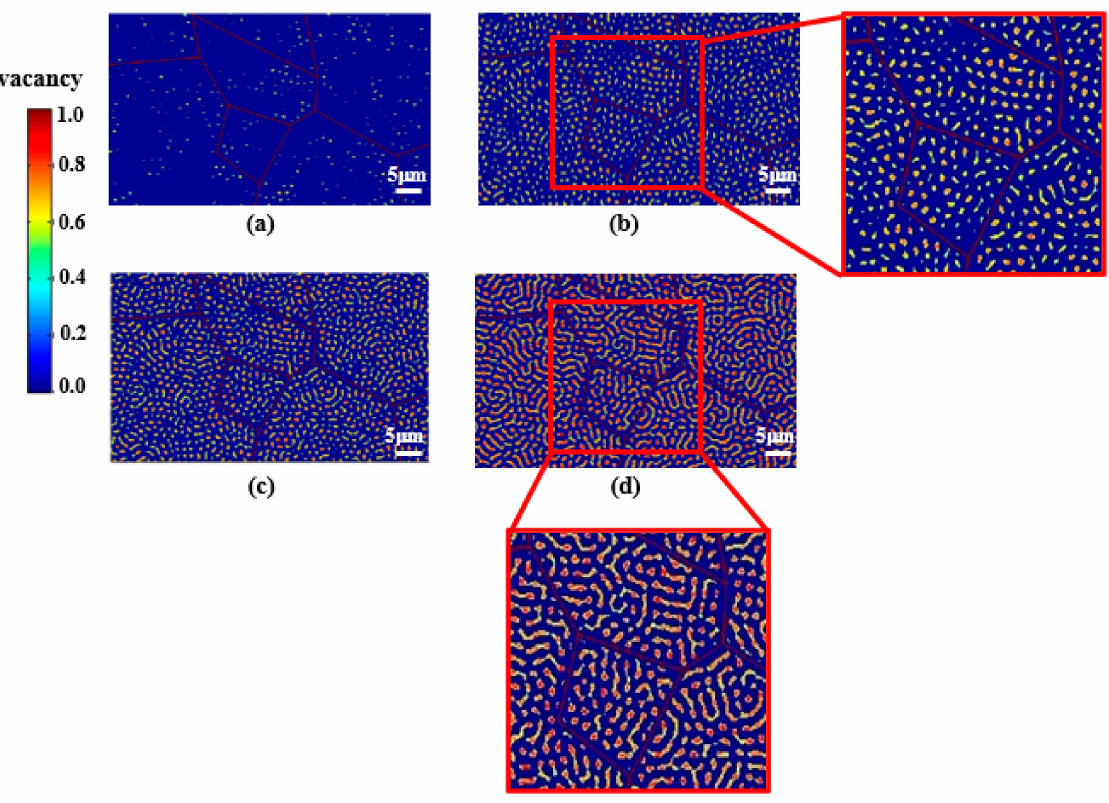
Figure 5. Temporal evolution of vacancy concentration in the W polycrystalline at T = 1000 K and E = 200 eV at the time of ( a ) t = 3.2 µ s; ( b ) t = 4.4 µ s; ( c ) t = 5.1 µ s; ( d ) t = 6.8 µ